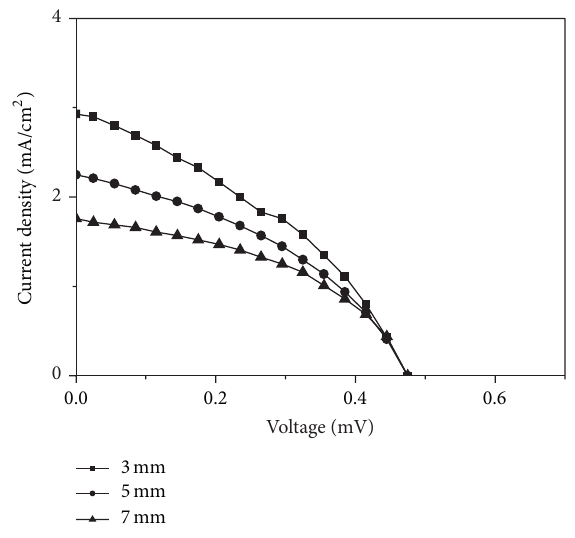
Figure 10: Photovoltaic curves ( J-V ) of the prepared 3D DSSC made by a carbon counter electrode at different cell heights.